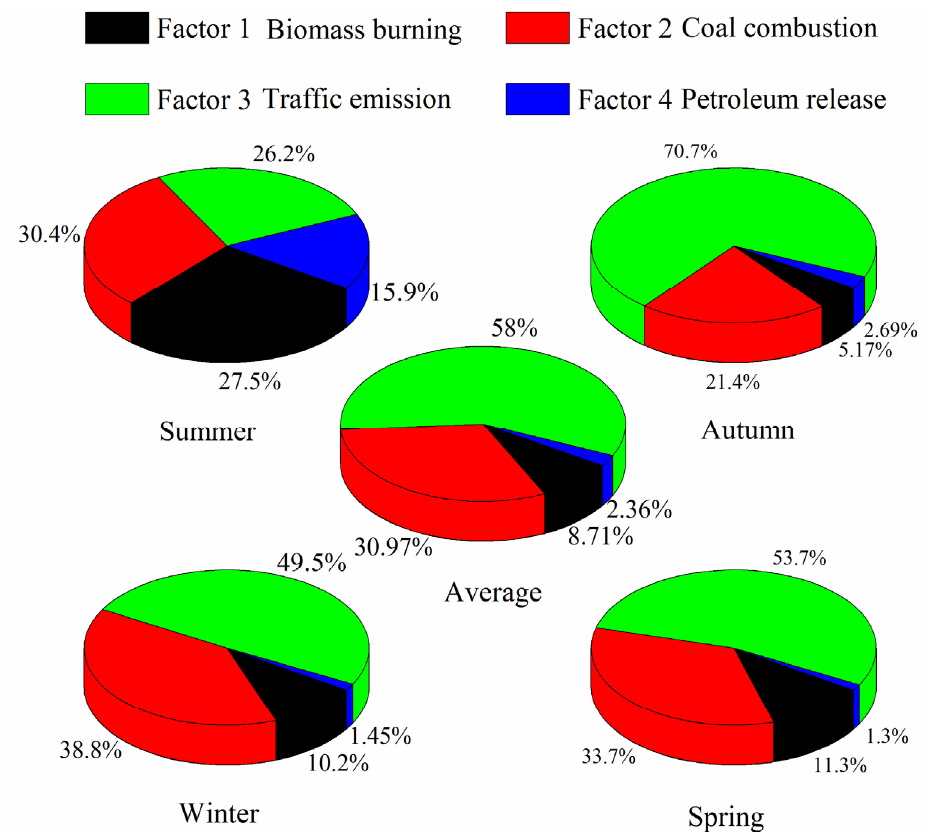
Σ BaPeq in PM 2.5 identified by the PMF